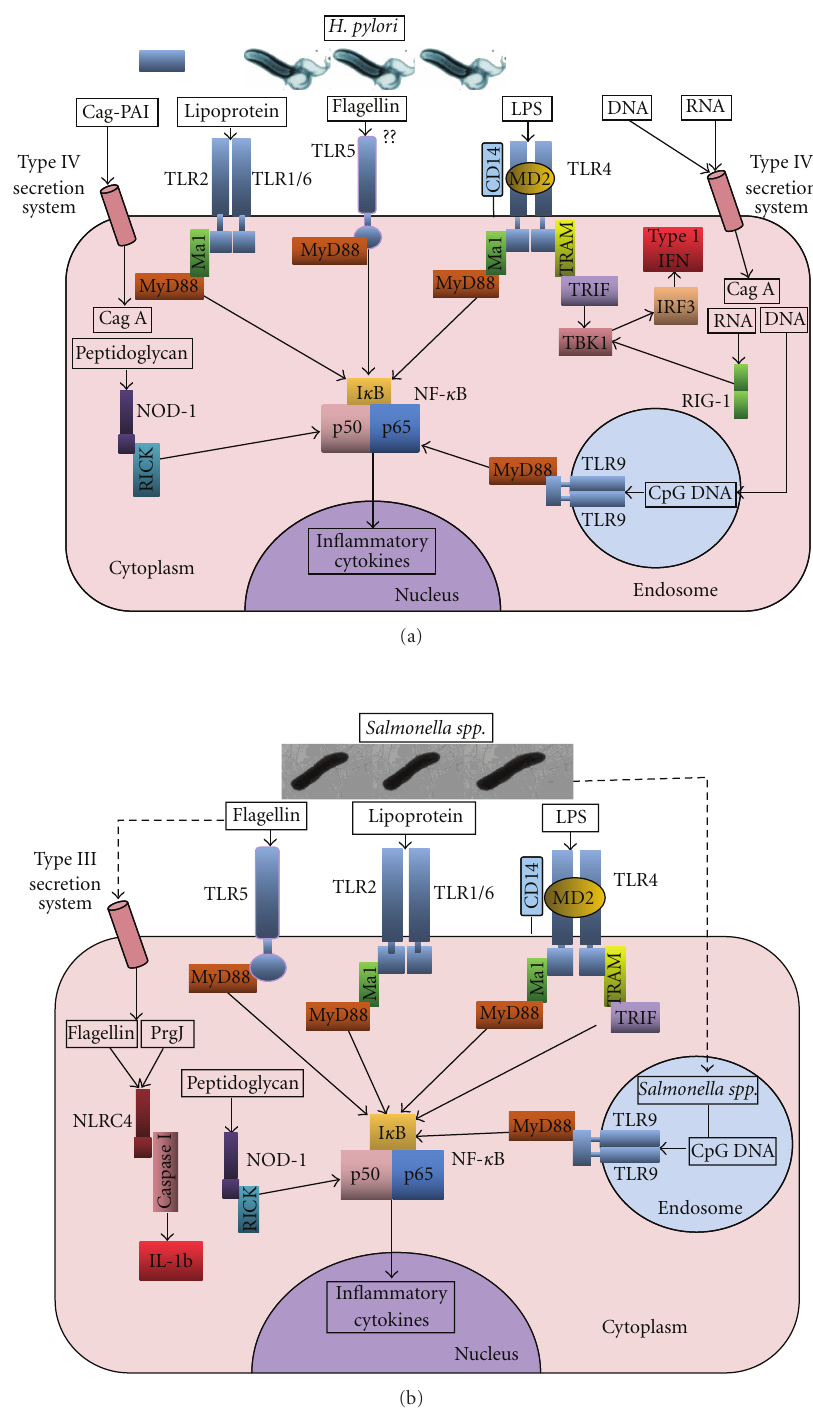
Figure 1: The interaction of Helicobacter pylori and Salmonella spp. with pattern recognition receptors. Schematic representations of the PRRs, activating ligands, and simplified activation pathways for innate immune signaling for (a) Helicobacter pylori and (b) Salmonella enterica serovar Typhimurium . Both pathogens activate multiple PRRs found on cellular membranes and in the cytoplasm. Together, this instigates a complex interplay of signaling crosstalk that influences the host response to the pathogen and results in induction of a proinflammatory immune response. In the case of Salmonella spp., activation of caspase-1 via NLRC4 ultimately leads to cell death via pyroptosis. H. pylori electron micrograph image provided courtesy of Professor Dave Kelly, University of She ffi eld, UK. Electron micrograph image of Salmonella enterica serovar Typhimurium provided courtesy of Professor Sangwei Lu, UC